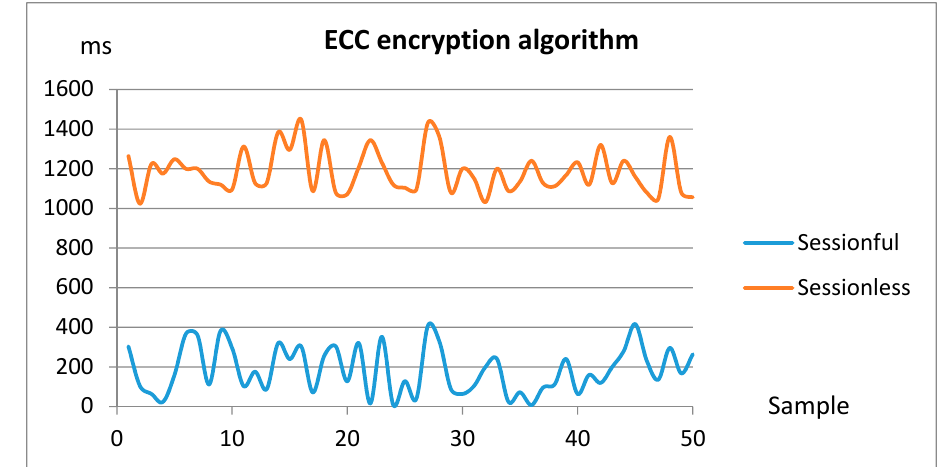
Figure 20 . Performance measurements with asymmetric data encryption. Figure 20. Performance measurements with asymmetric data